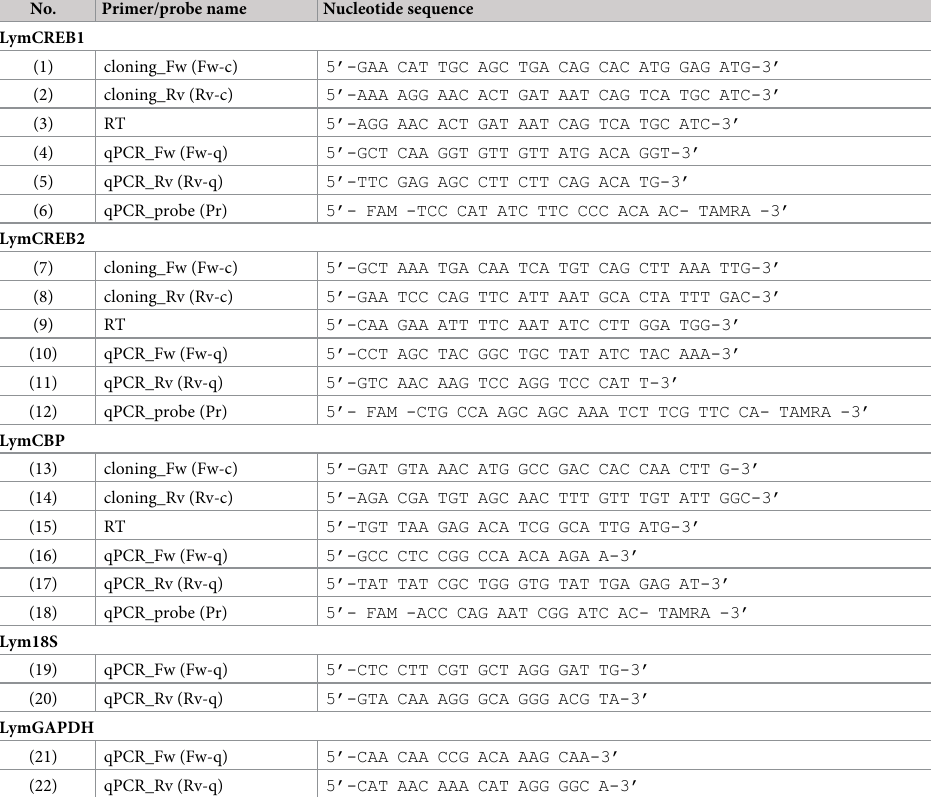
Table 1. Nucleotide sequences of primers and probes used in the experiments.